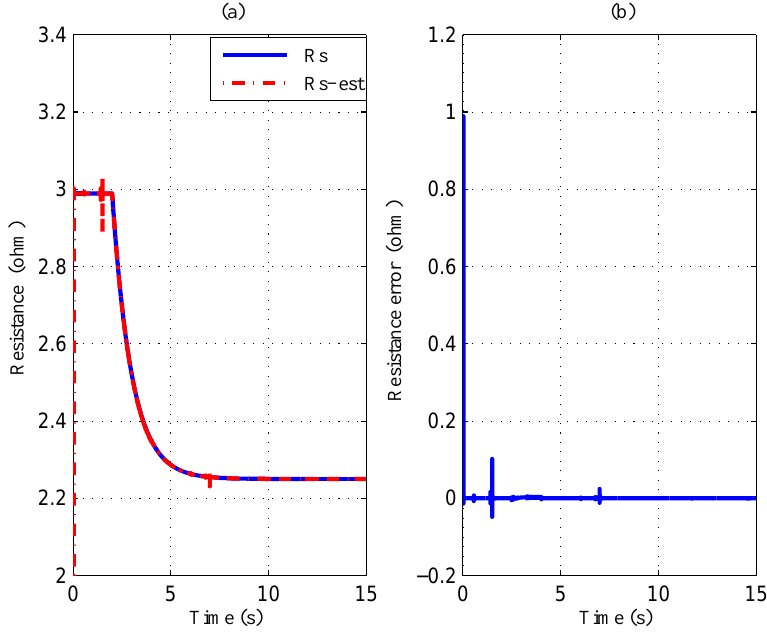
Figure 7. Robustness w.r.t. − 30% R s : ( a ) observed and measured speeds; and ( b ) speed error.